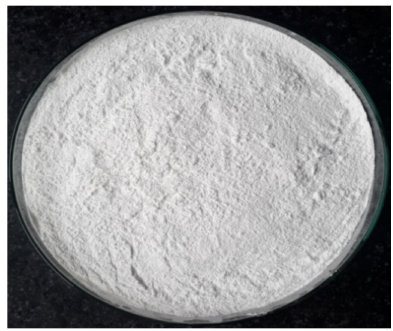
Figure 2. Proso millet